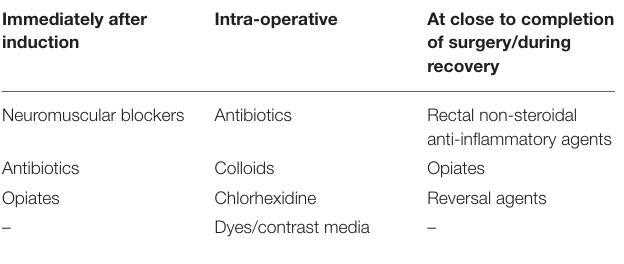
TABLE 2 | Timing of onset of anaphylaxis as a clue to underlying etiology. Immediately after